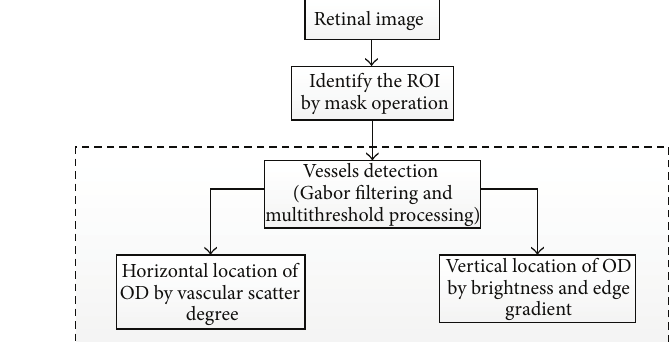
Figure 19: Flowchart for algorithm proposed in [38].